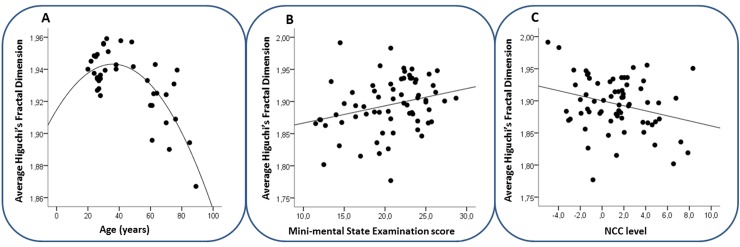
Scatter plot of average whole-brain HFD values of A) Healthy subjects in relationship with age (years), with the best fitting curve (R2 = .575, p < .001); B) AD patients with MMSE scores. We considered that MMSE values do not distribute as a Gaussian, reporting the Spearman’s correlation in the results. Nevertheless, for graphical representation we reported the line corresponding to the Pearson’s correlation (also below significance threshold r = .264, p = .031). C) AD patients with NCC levels, with best fitting line (r = -.274, p = .025).